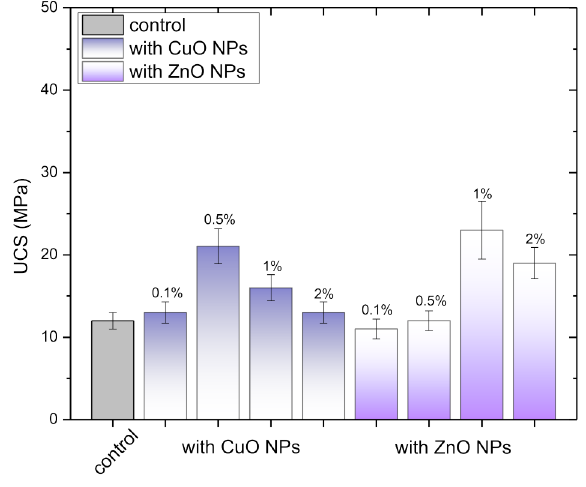
Figure 3. Compressive strength of CuO and ZnO NPs blended GWC IPs specimens (control: GWC IPs). Replicates of two IPs specimens (~10% standard error).